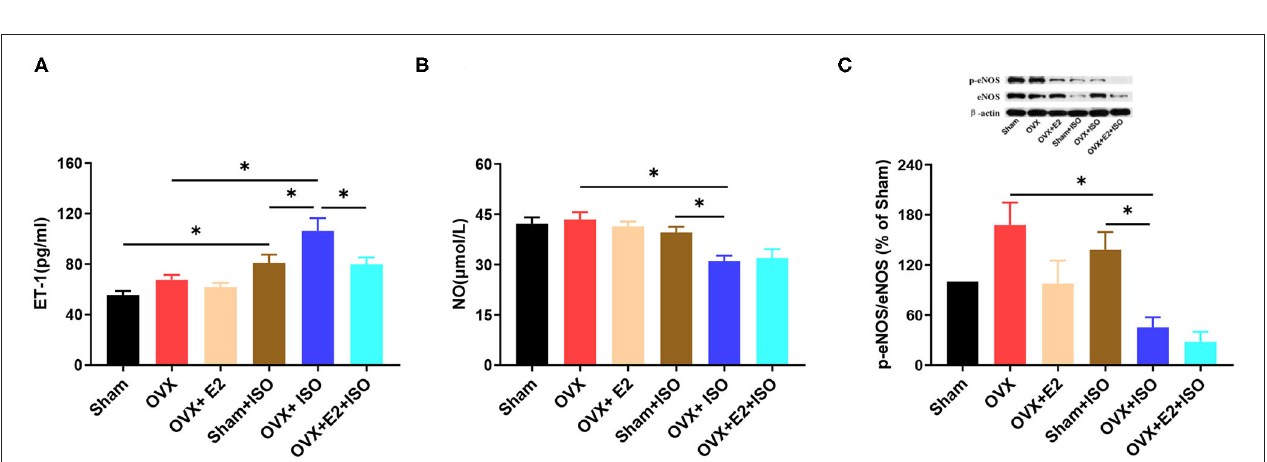
FIGURE 4 | Estrogen downregulates vasoconstrictors and upregulates vasodilators during catecholamine stress. (A) The expression of serum ET-1. n = 6. (B) The expression of serum NO. n = 6. (C) The protein expression of p-eNOS/eNOS in aortic tissues. n = 3. Data are expressed as mean ± SEM. * P <